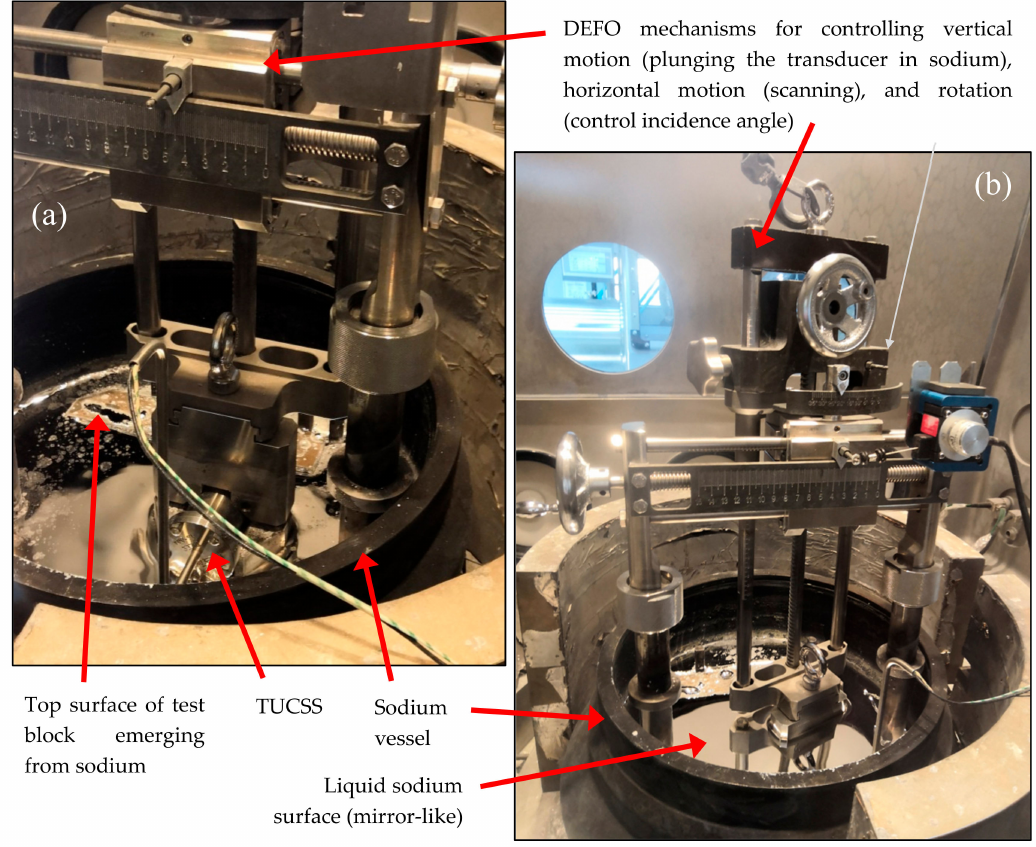
Figure 5. Photographs of experiment ( a ) before immersion of the transducer and ( b ) when the transducer is